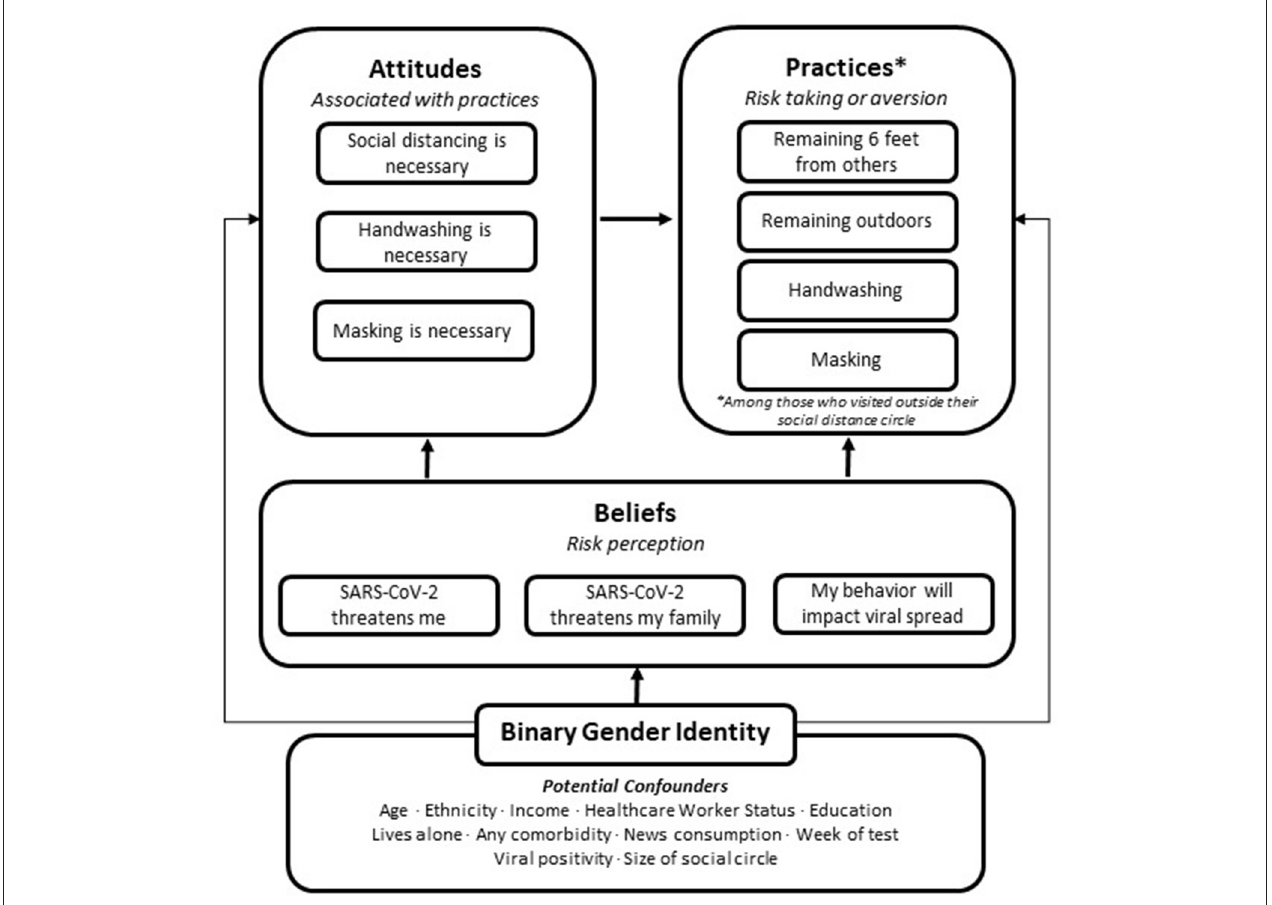
FIGURE 1 | Conceptual framework for the relationship between binary gender identity and early-stage pandemic beliefs, attitudes, and practices.